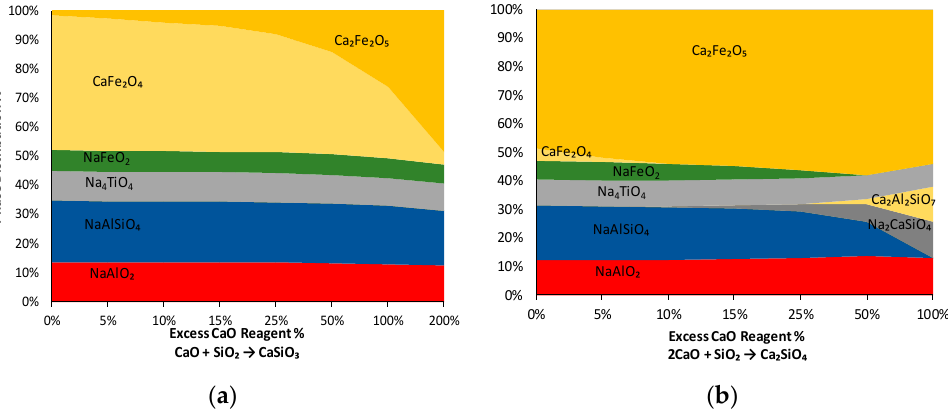
Figure 12. Thermodynamic predictions of sinter phase formation ( a ) when monocalcium silicate is expected or ( b ) when dicalcium silicate is expected, at excess of lime additions at 50% excess soda, 900 °C for 2 h.